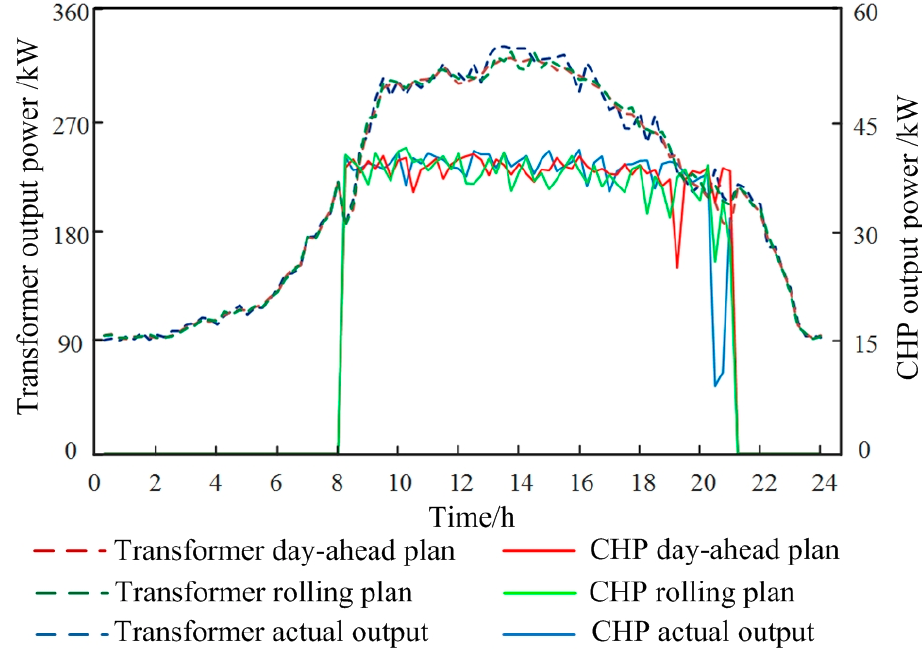
Figure 6. Comparison of electricity load day plan, rolling plan and actual output.